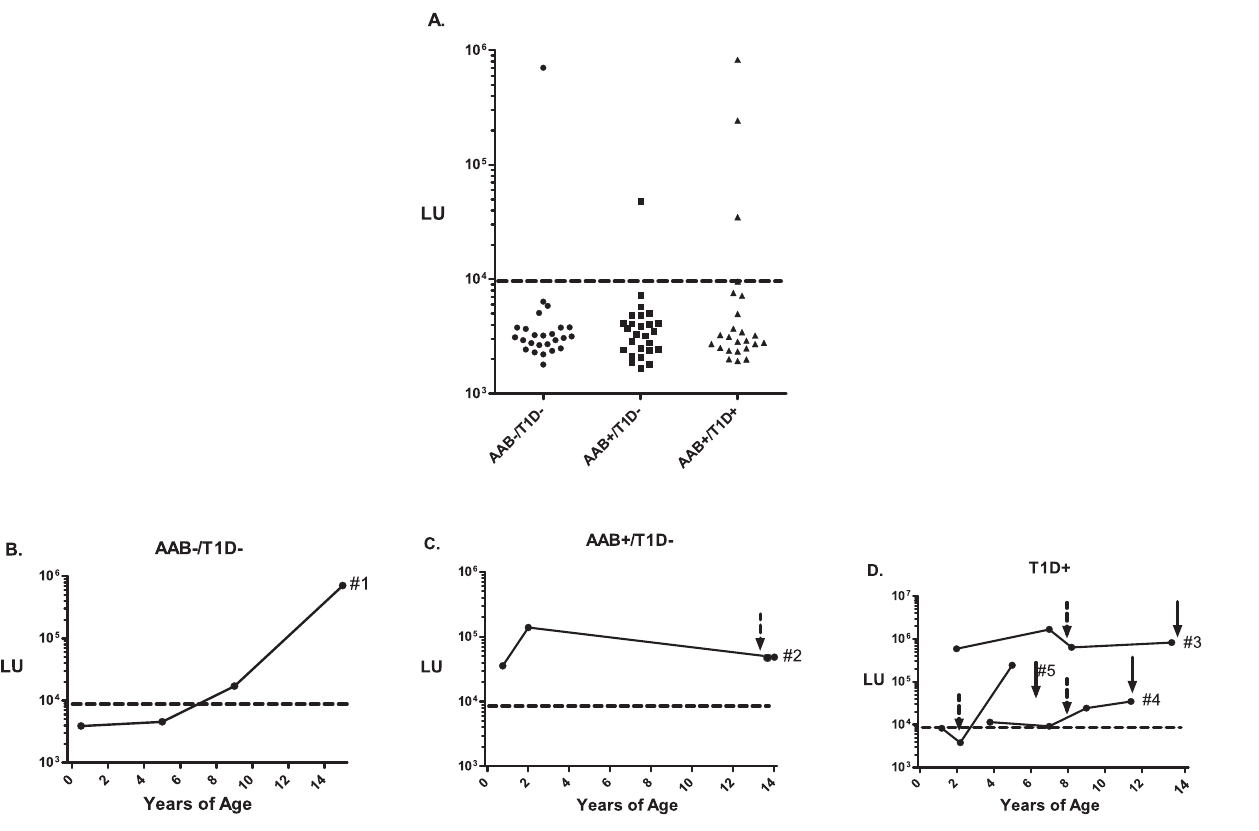
Figure 4. Predictive value of anti-gastric autoantibodies in high risk children. ( A ) Anti-ATP4B autoantibodies were evaluated in pediatric serum samples (n=75) from the high risk DAISY cohort containing three clinically defined subgroups: islet autoantibody negative and T1D negative (AAB 2 /T1D 2 ), islet autoantibody positive but currently without T1D (AAB + /T1D), and islet autoantibody positive and diagnosed with T1D (AAB + / T1D + ). Only the last available longitudinal serum sample from these children was initially evaluated. The autoantibody titers are plotted on the Y-axis using a log 10 scale. The dashed line represents the previous cut-off level for determining seropositivity. ( B ) The five seropositive children were further analyzed for anti-ATP4B autoantibodies using available longitudinal serum samples. The titer value shown for the last serum sample was taken from the results obtained in panel A. The stippled arrow represents the age of first detectable islet autoantibodies and the solid arrow marks the time of T1D onset. The dashed line represents the cut-off for determining seropositivity and was represents the ATP4B cut-off value from the DASP 2010 samples. interval for ( A ) GAD65, ( B ) IA2, and ( C ) IA2- b in the 90 controls and 50 T1D subjects were plotted on the Y-axis using a log 10 scale. Each symbol represents a sample from one individual. The mean is shown by the short line with 95% CI error bars. The dashed line represents the cut-off level for determining seropositivity and is derived from the mean plus 3 standard deviations of the antibody titer of the controls. P values for the different groups were calculated using the Mann Whitney U test. Figure S2 Autoantibodies against ZnT8 in the DASP 2010 samples. Autoantibodies against ZnT8-R and ZnT8-W were evaluated in the DASP 2010 samples containing 50 T1D patients and 90 controls. Each symbol in the scatterplots represents serum from one subject and the autoantibody titers for are plotted on the Y-axis using a log 10 scale. The dashed lines represent the cut-off levels used for determining seropositivity and are derived from the mean plus 3 SD of the antibody titer of the 90 controls. Figure S3 Antibody profiling candidate autoantigens in T1D and control subjects. Autoantibodies were evaluated in